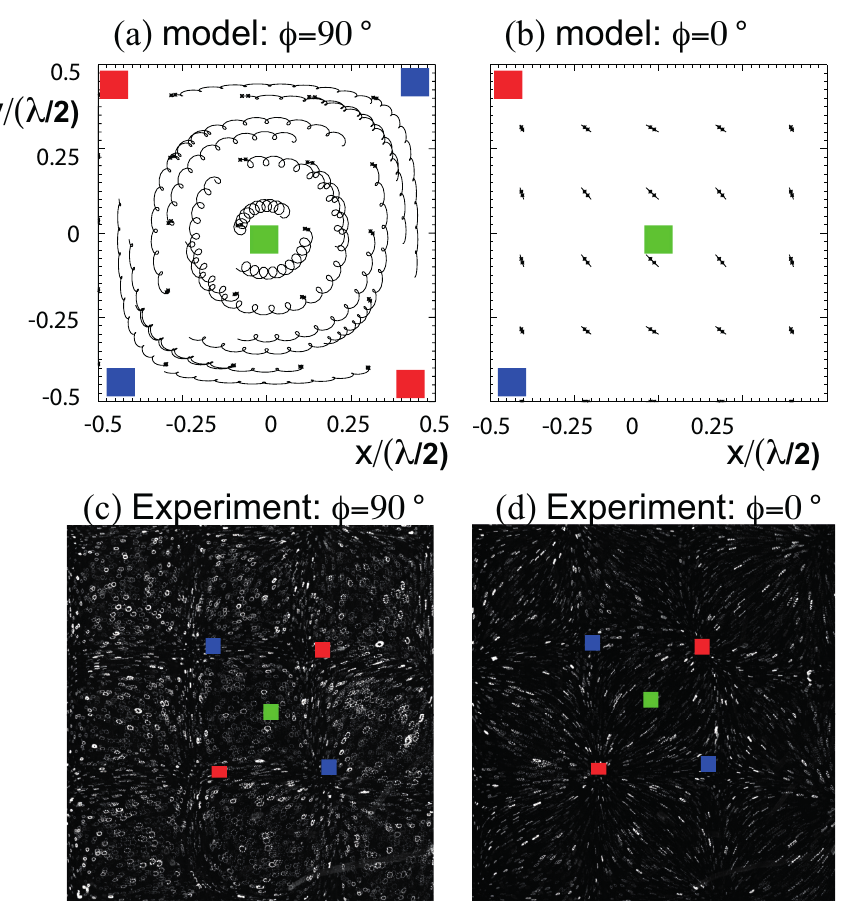
Figure 5. Numerically integrated particle trajectories for ( a ) φ = 90 ◦ , and ( b ) φ = 0 ◦ . The particles were tracked for 10 periods. Experimental particle trajectories for ( c ) φ = 90 ◦ , and ( d ) φ = 0 ◦ . The particles were tracked for one period. Experimental parameters: 300 mm cavity, f = 3.8 Hz, a / λ =